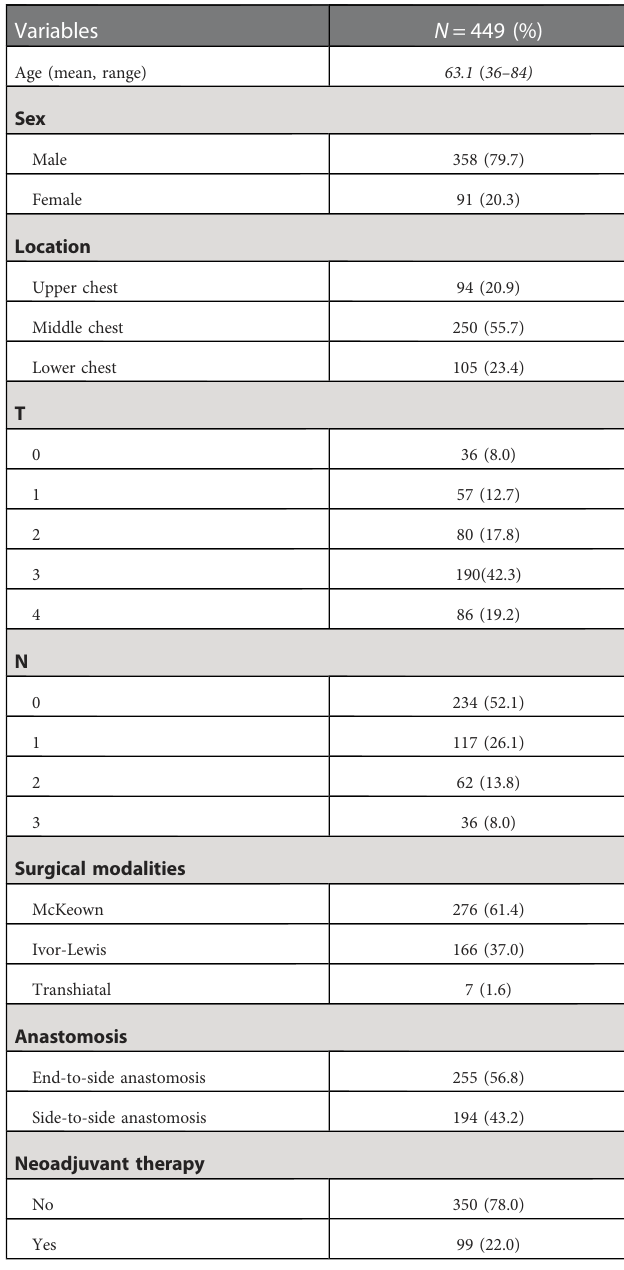
TABLE 2 Patient characteristics and preoperative